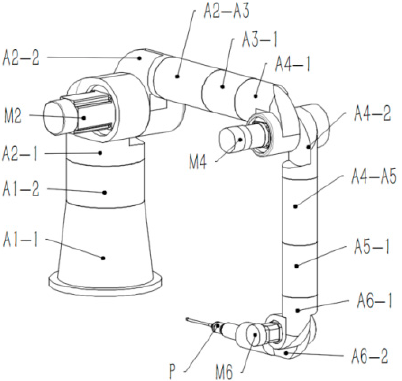
Figure 3. 3D model of the self-driven AACMM.